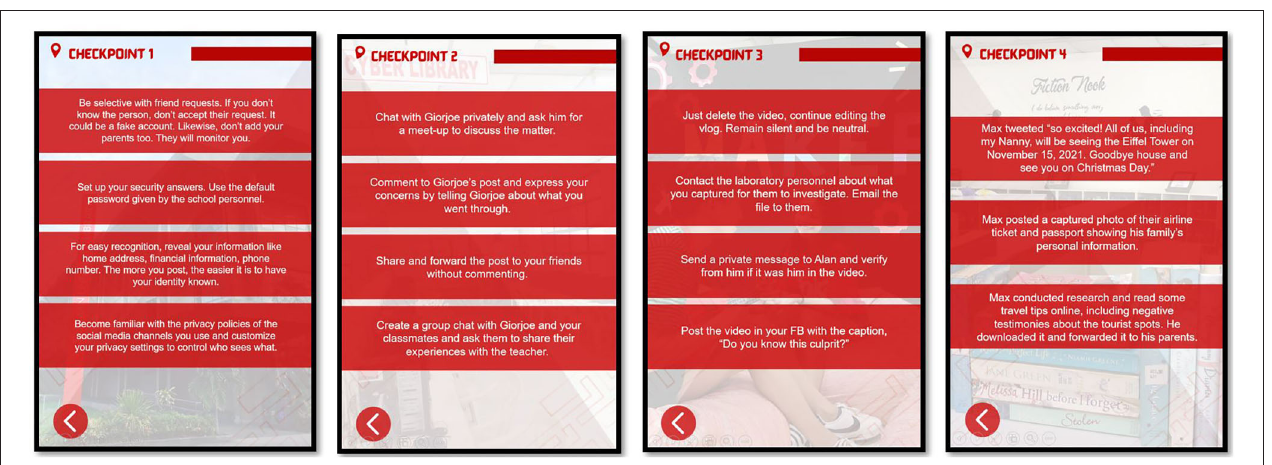
FIGURE 6 | User Interface of the